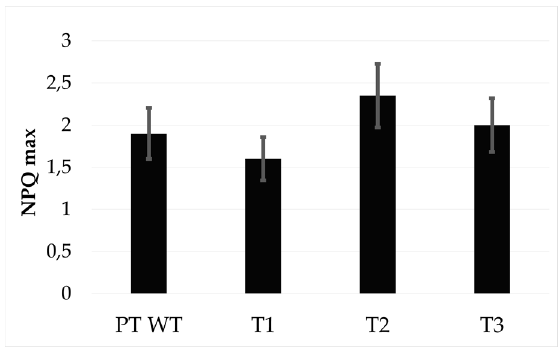
Figure 5. Non-photochemical quenching (NPQ max) developed by the four strains analysed.